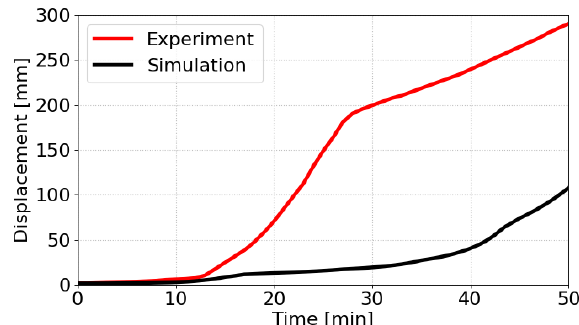
Figure 19. Comparison of the experimental and calculated displacements for beam #1.